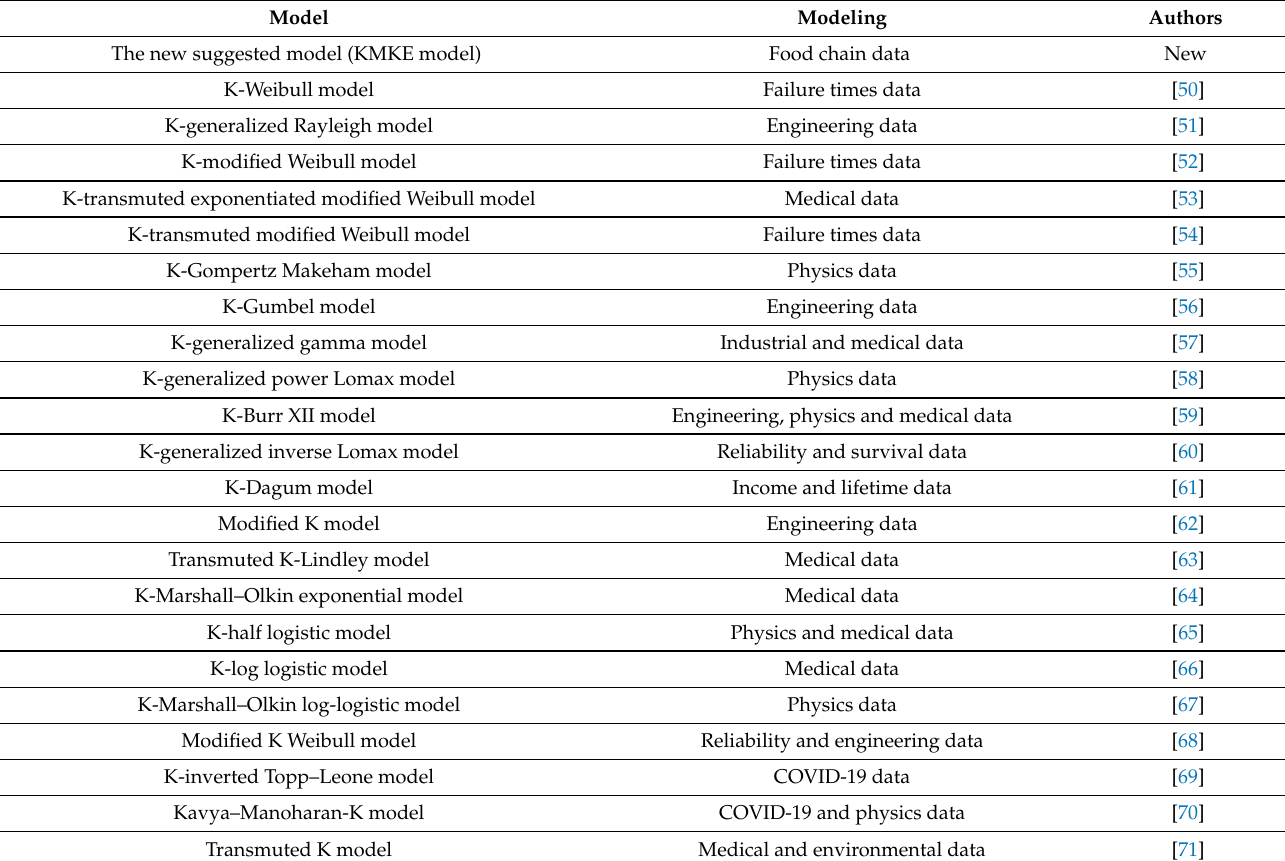
Table 1. Relevant